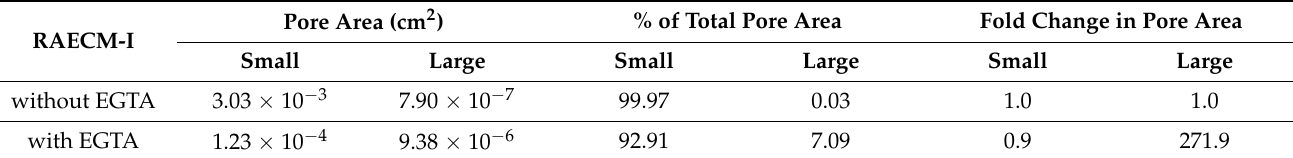
The relationship between P app of hydrophilic solutes across RAECM-II and solute radius is depicted in Figure 2A (at baseline) and Figure 2B (with EGTA treatment). The unbroken lines in Figure 2 represent the best-fit relationship between the P app for all individual data points for RAECM-II (at baseline and with EGTA, respectively) and solute radius, obtained by maximum likelihood approach. Dotted lines in Figure 2 represent the upper and lower error limits for the best-fit curves represented by unbroken lines. As seen, P app